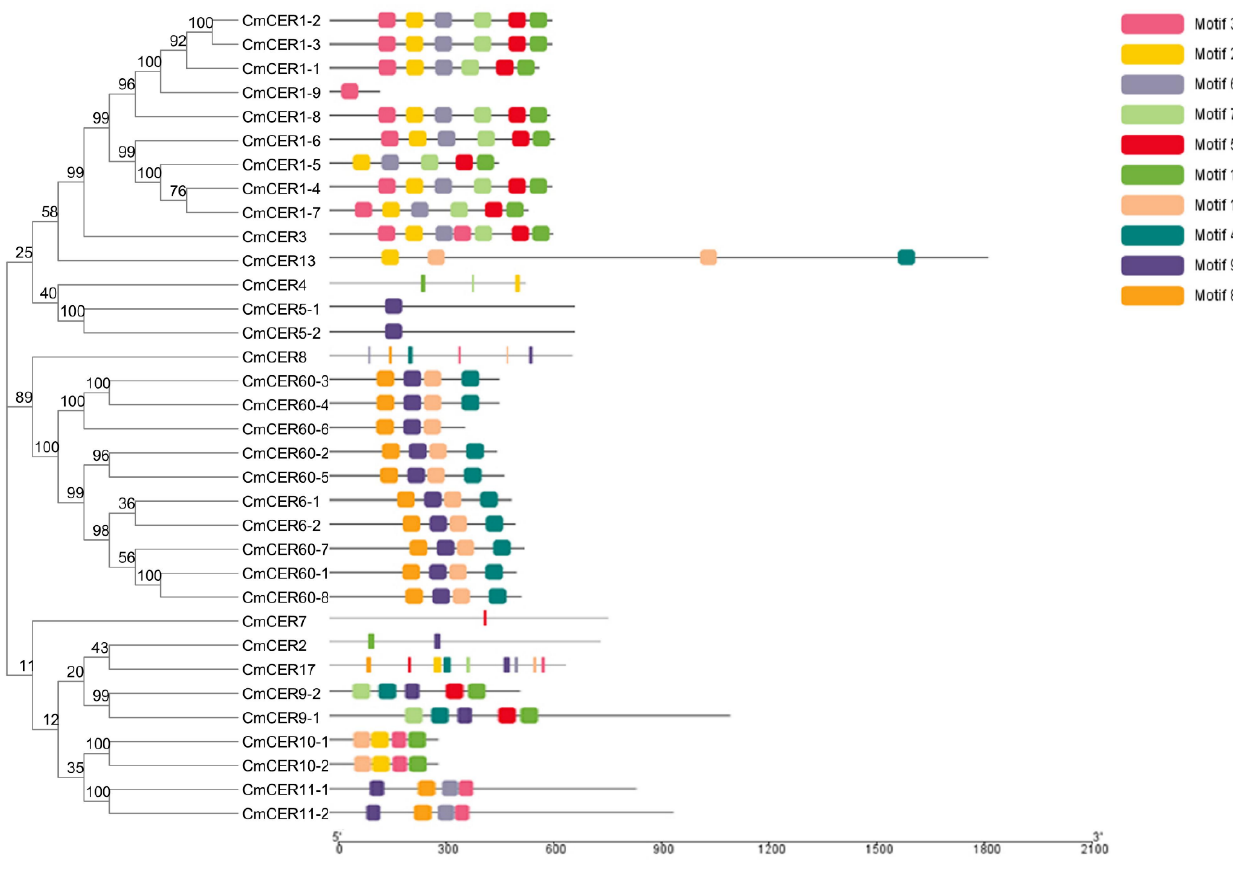
Figure 4. Distribution of conserved motifs in CmCERs . Individual motifs are indicated in different- colored horizontal bars below each figure. Numbers on the X-axis indicate amino-acid positions of the proteins.